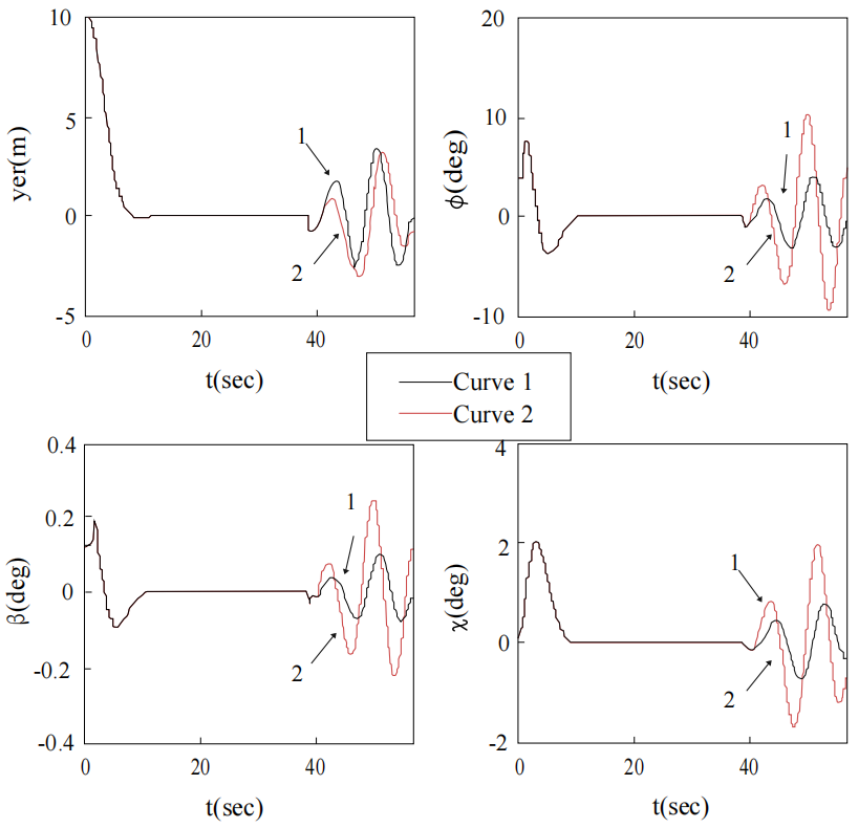
Figure 30. The compensation effect curve of ACLS Lat for deck motion with yaw compensation commands.